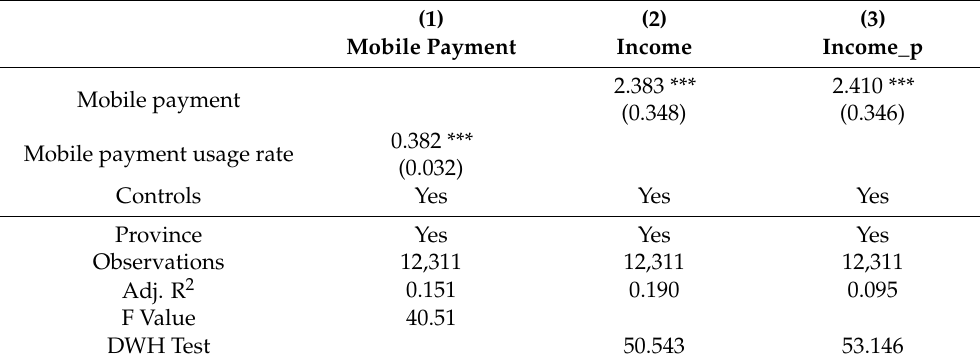
Table 5. The impact of mobile payment on rural household income: the IV Model.